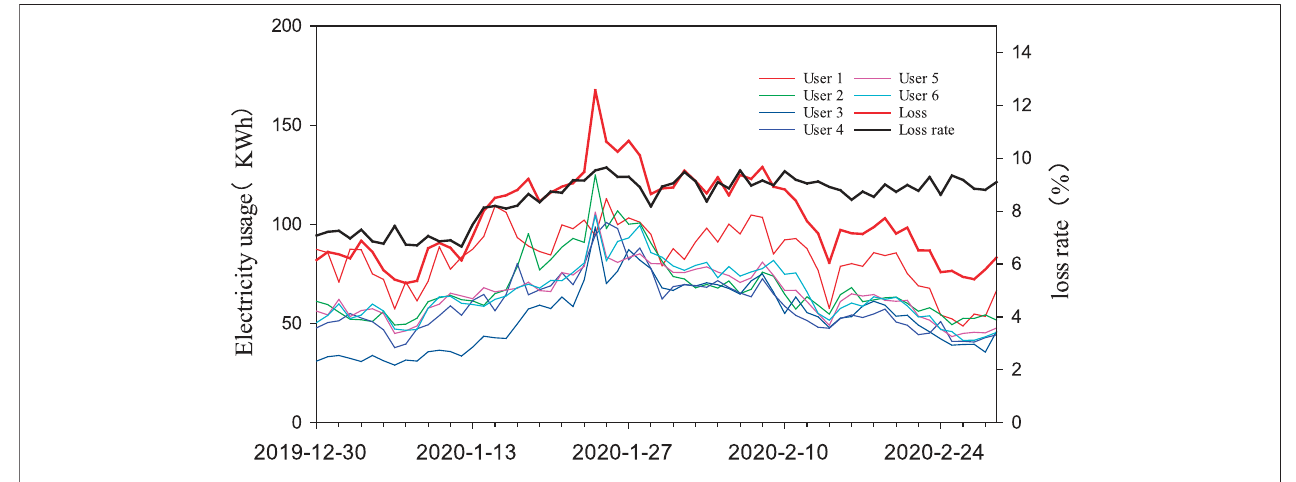
FIGURE 1 | Electricity usage of users and loss of DTSZ with a high loss